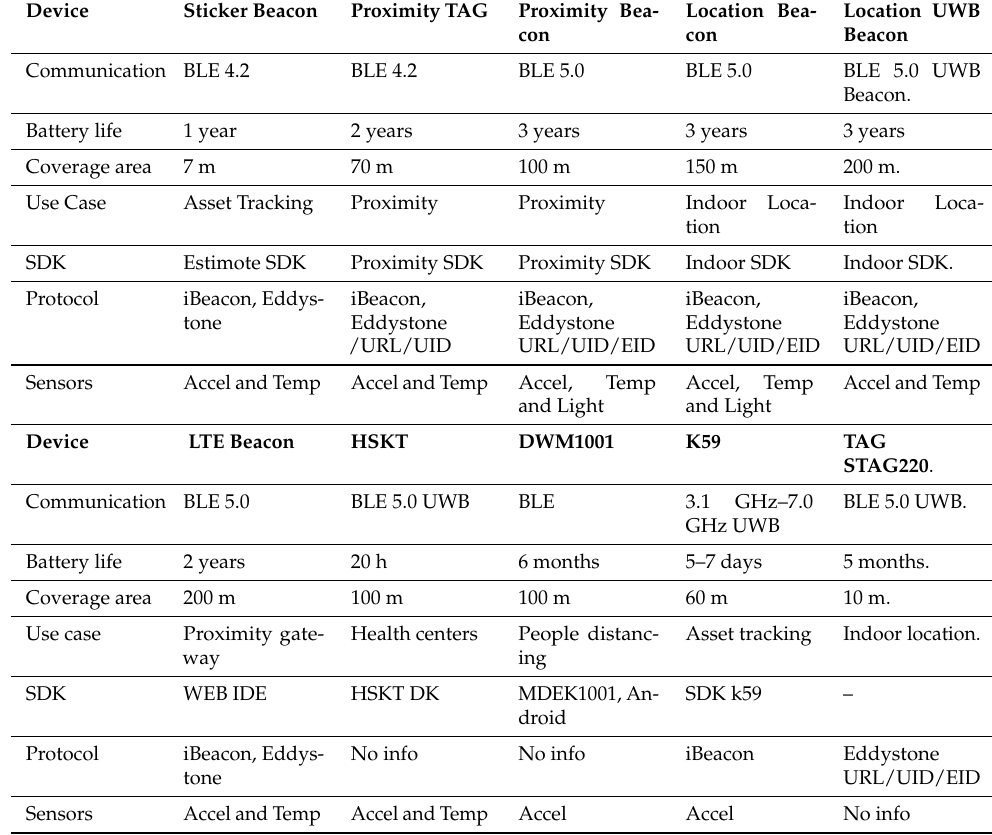
Table 1. Comparison table of academic and commercial initiatives (taken from